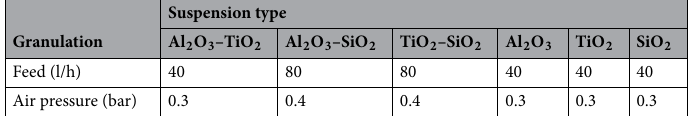
Table 3. The atomization parameters on a per type of granule basis.